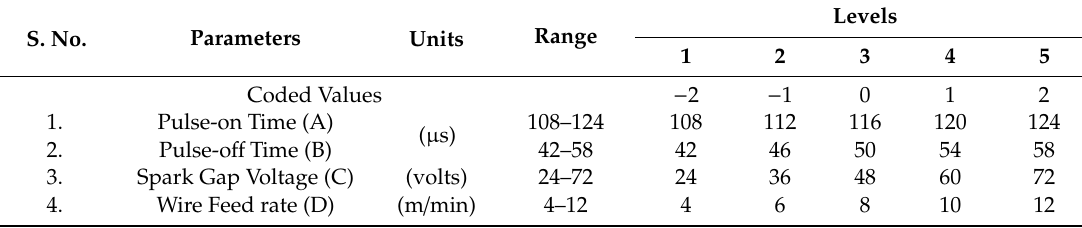
Table 2. Parameters and levels selected through preliminary